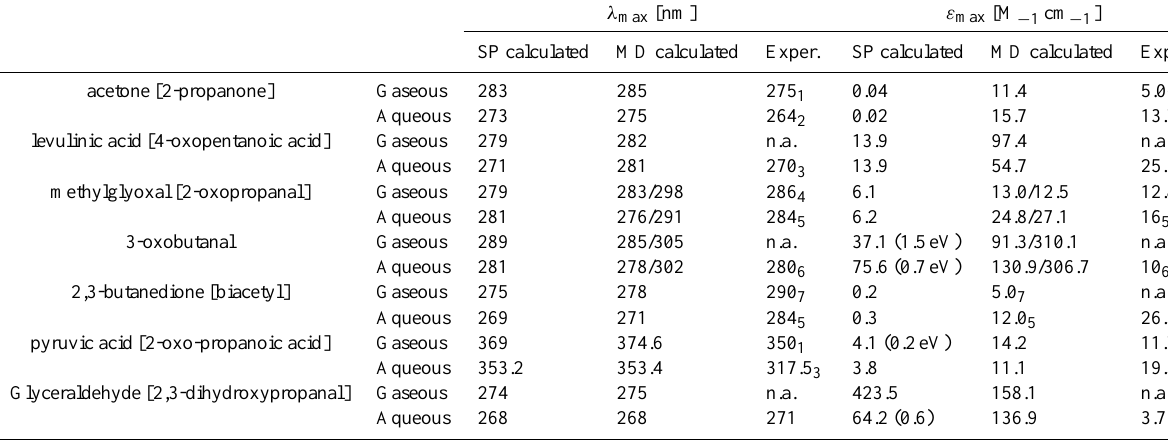
Table 1. Calculated wavelength of maximum absorption λ max (nm) and decadic molar absorption coefficients ε max (M − 1 cm − 1 ) of the reference compounds. Only the absorption band closest to 280nm is reported. In cases where two absorption peaks were predicted in the 280nm region, both values are reported. MD denotes that the spectra have been computed by averaging over several structures obtained from MD simulations. Values of FWHM used to calculate the molar absorption coefficients are reported in parentheses. Subscripted numbers indicate the references used for the experimental parameters: Ref. 1 (Horowitz et al., 2001), Ref. 2 (Xu et al., 1993), Ref. 3 (Mackinney and Temmer, 1948), Ref. 4 (Chen et al., 2000), Ref. 5 (Schutze and Herrmann, 2004), Ref. 6 (Martinez et al., 1975), and Ref. 7 (Bayrakçeken, 2007). Aqueous λ max and ε max of glyceraldehyde were obtained from this work. A full set of computed spectra and structures of these compounds are shown in Figs.